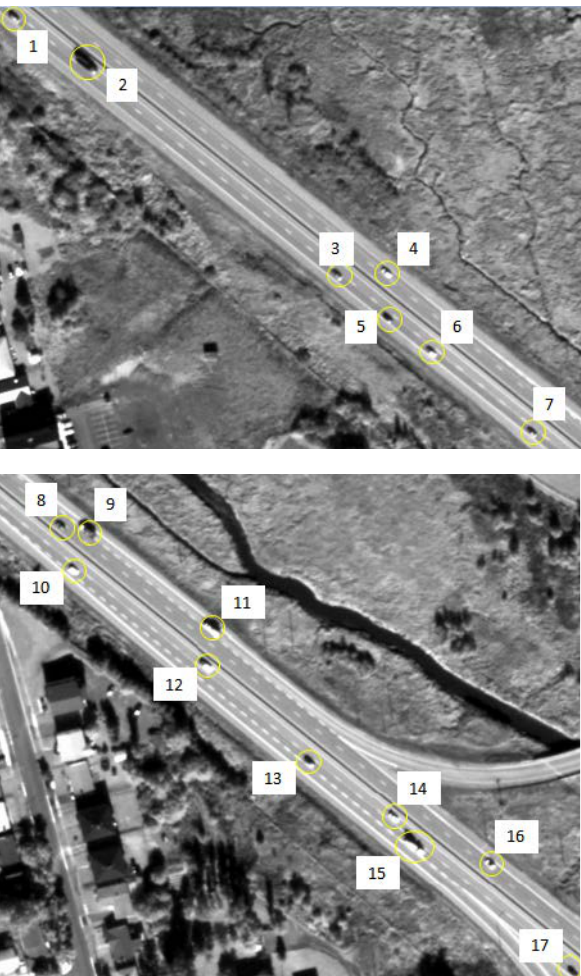
Figure 8: Test vehicles on Pan imagery for speed